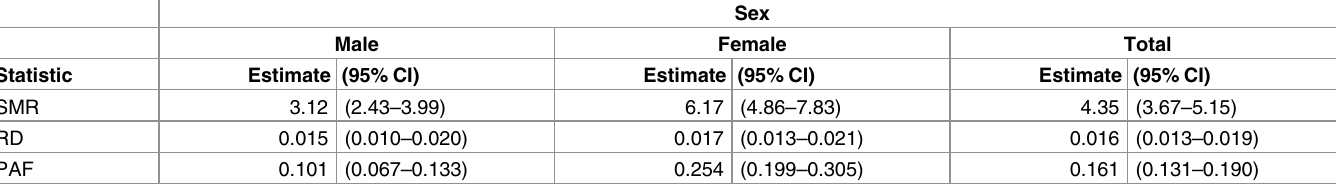
Table 4. Risk difference (RD), standardized mortality rate (SMR) and population attributable fraction (PAF) due to HIV, Nairobi